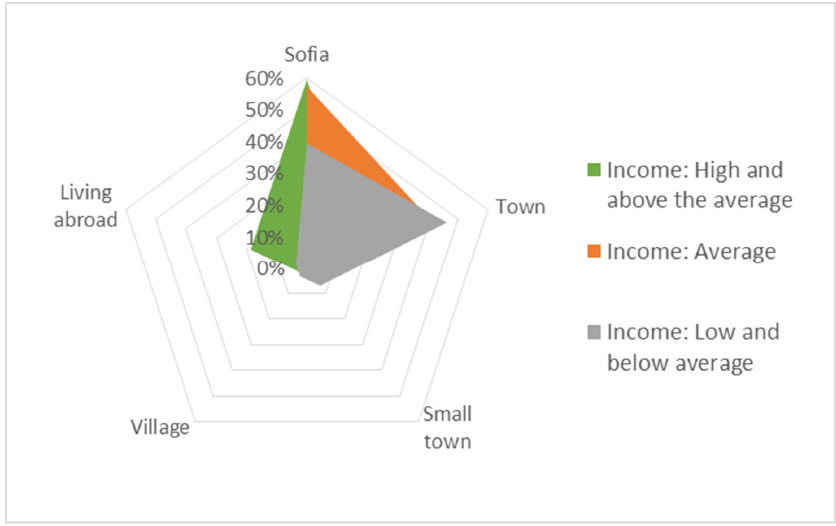
Figure 1. Respondent distribution per income and location. N = 142.